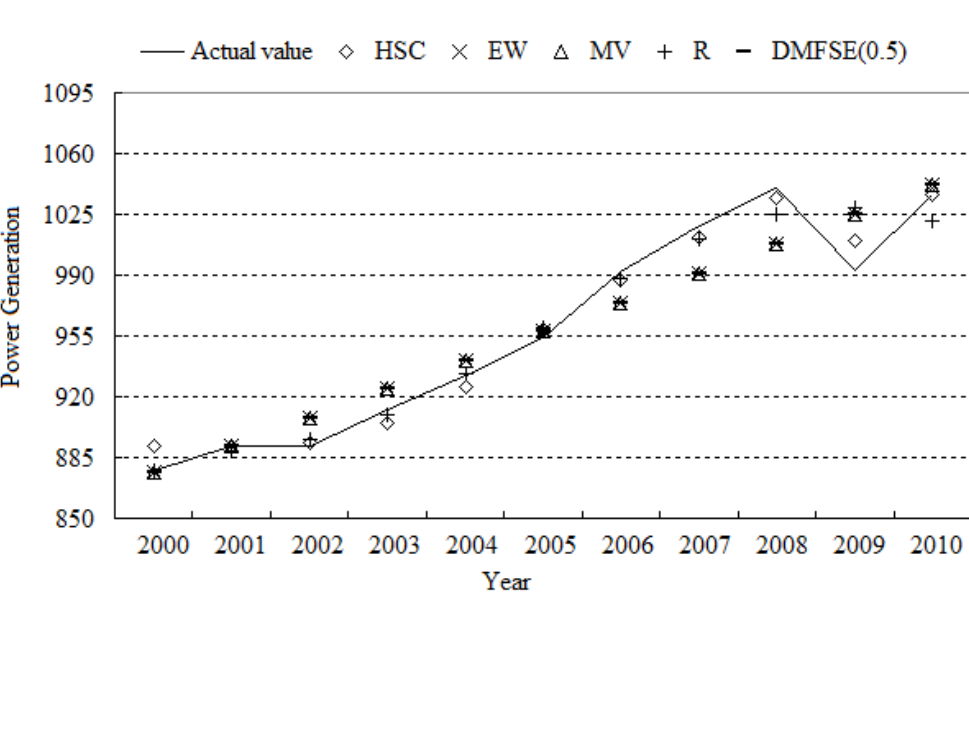
Figure 8. Forecasting performance of the HS-based JPOC model and the other combination models for the Russian